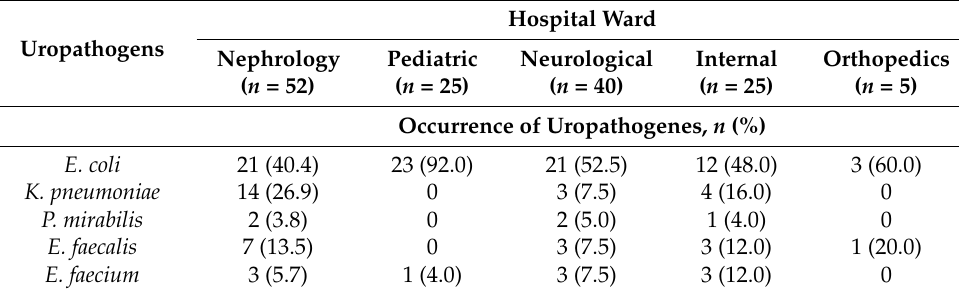
Table 5. The prevalence of major uropathogens in different hospital